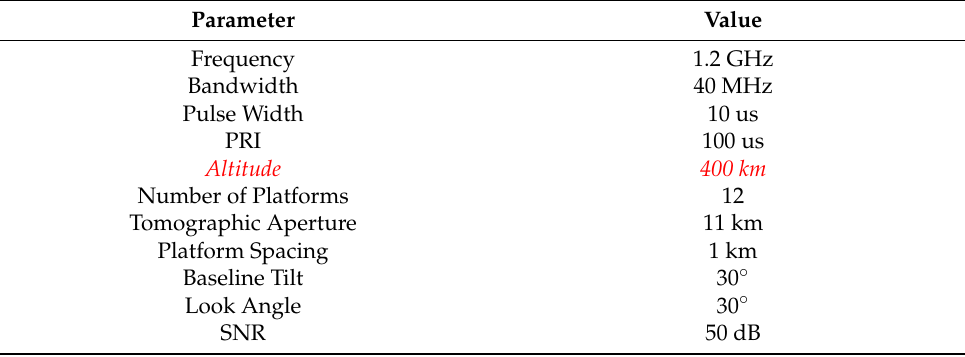
Table 8. Parameters used for Example